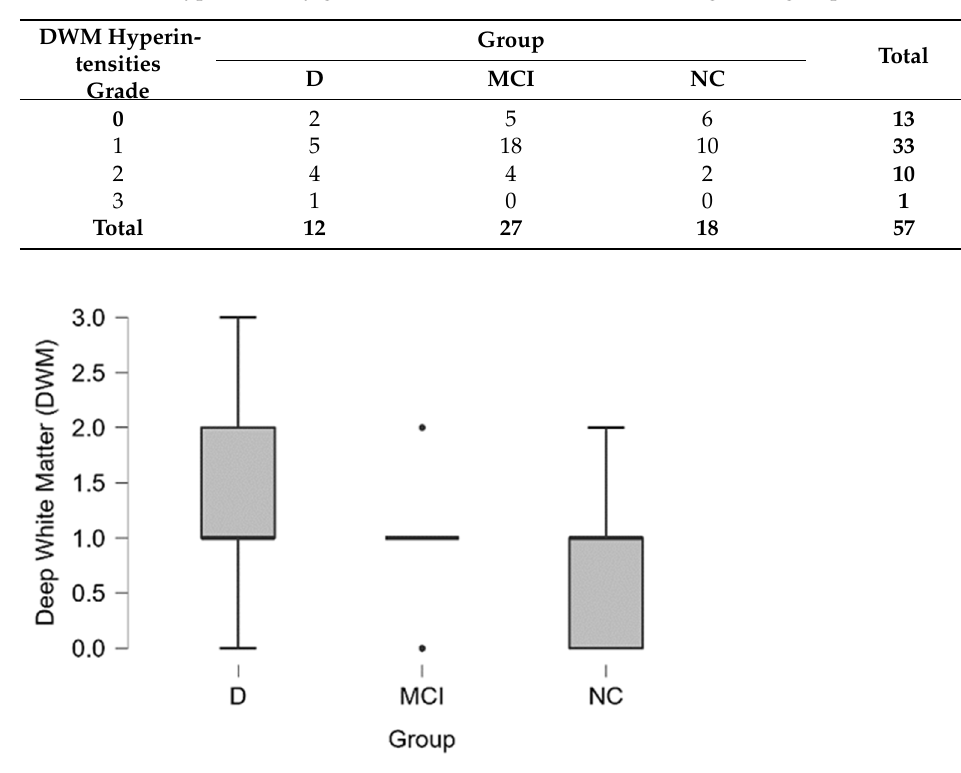
Table 7. DWM hyperintensity grade in dementia, MCI and normal cognition groups.